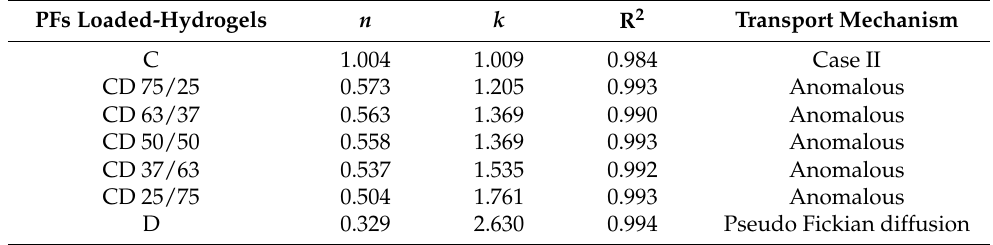
Table 6. Kinetic parameters of PFs release for C, D and CD hydrogels. PFs